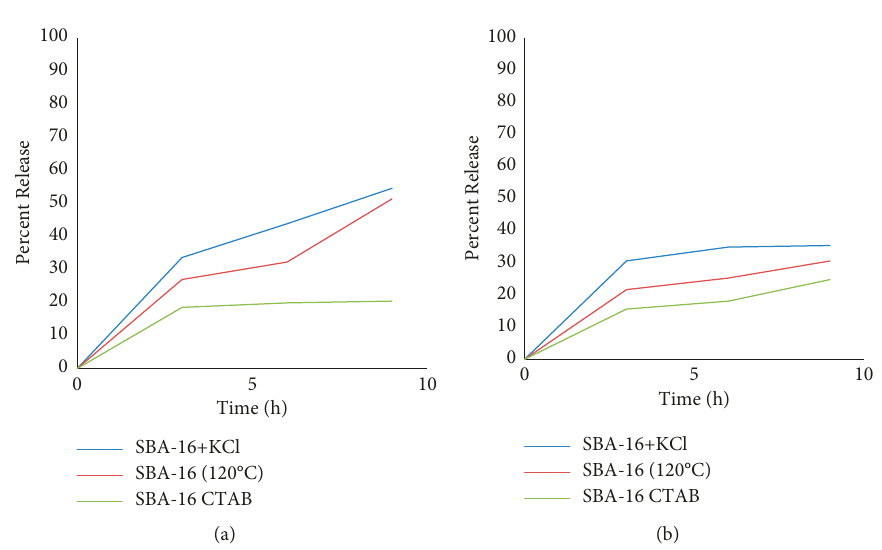
Figure 8: Release of IBU at acidic pH. (a) Release of IBU at 0.015g. (b) Release of IBU at